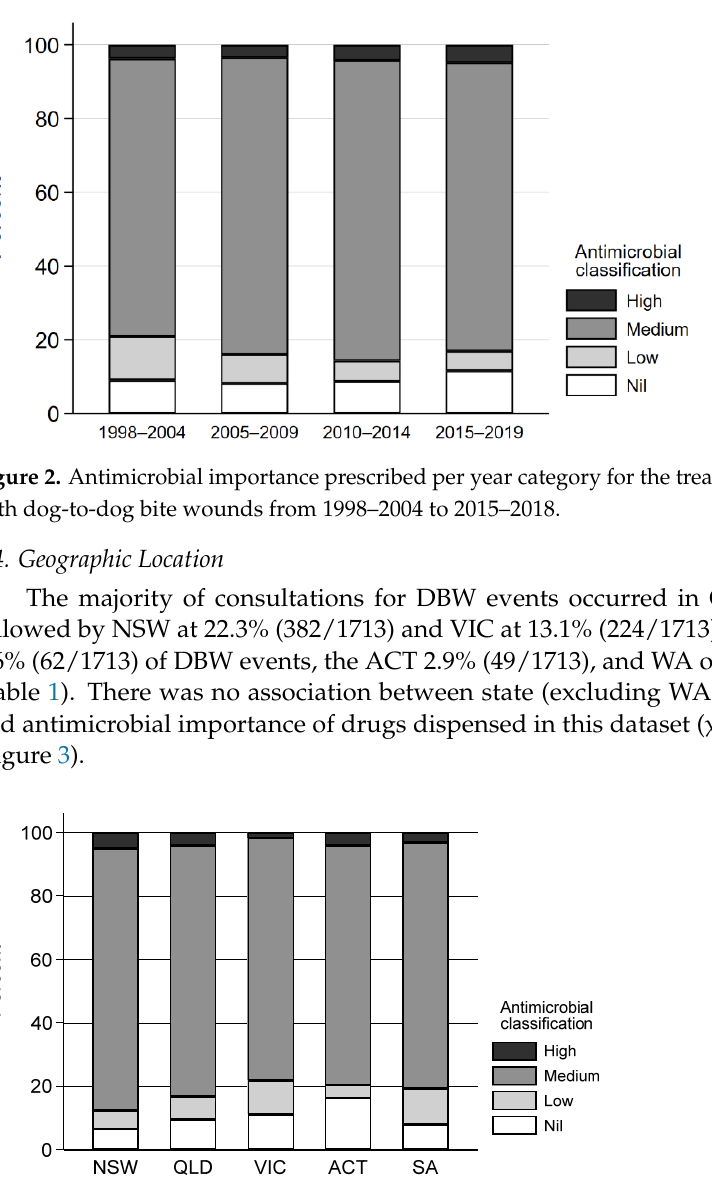
Figure 3. Antimicrobial importance prescribed per state (excluding WA due to low numbers) for the treatment of dogs presenting with dog-to-dog bite wounds from 1998 to 2018.